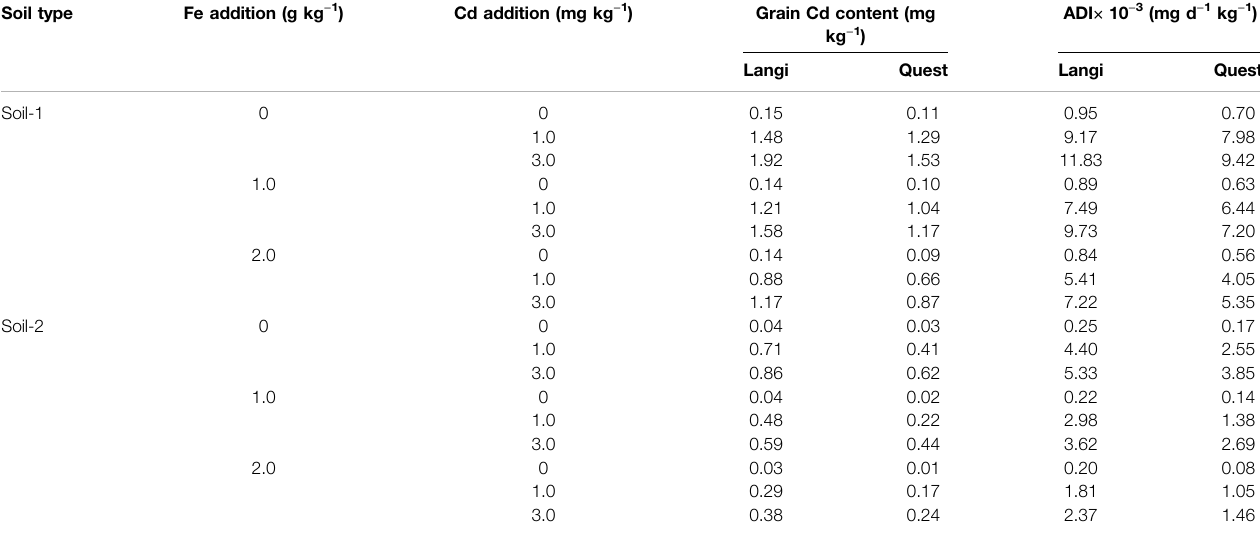
TABLE 6 | Concentrations of Cd in grain when soils were treated with Cd and Fe and daily Cd exposure. Soil